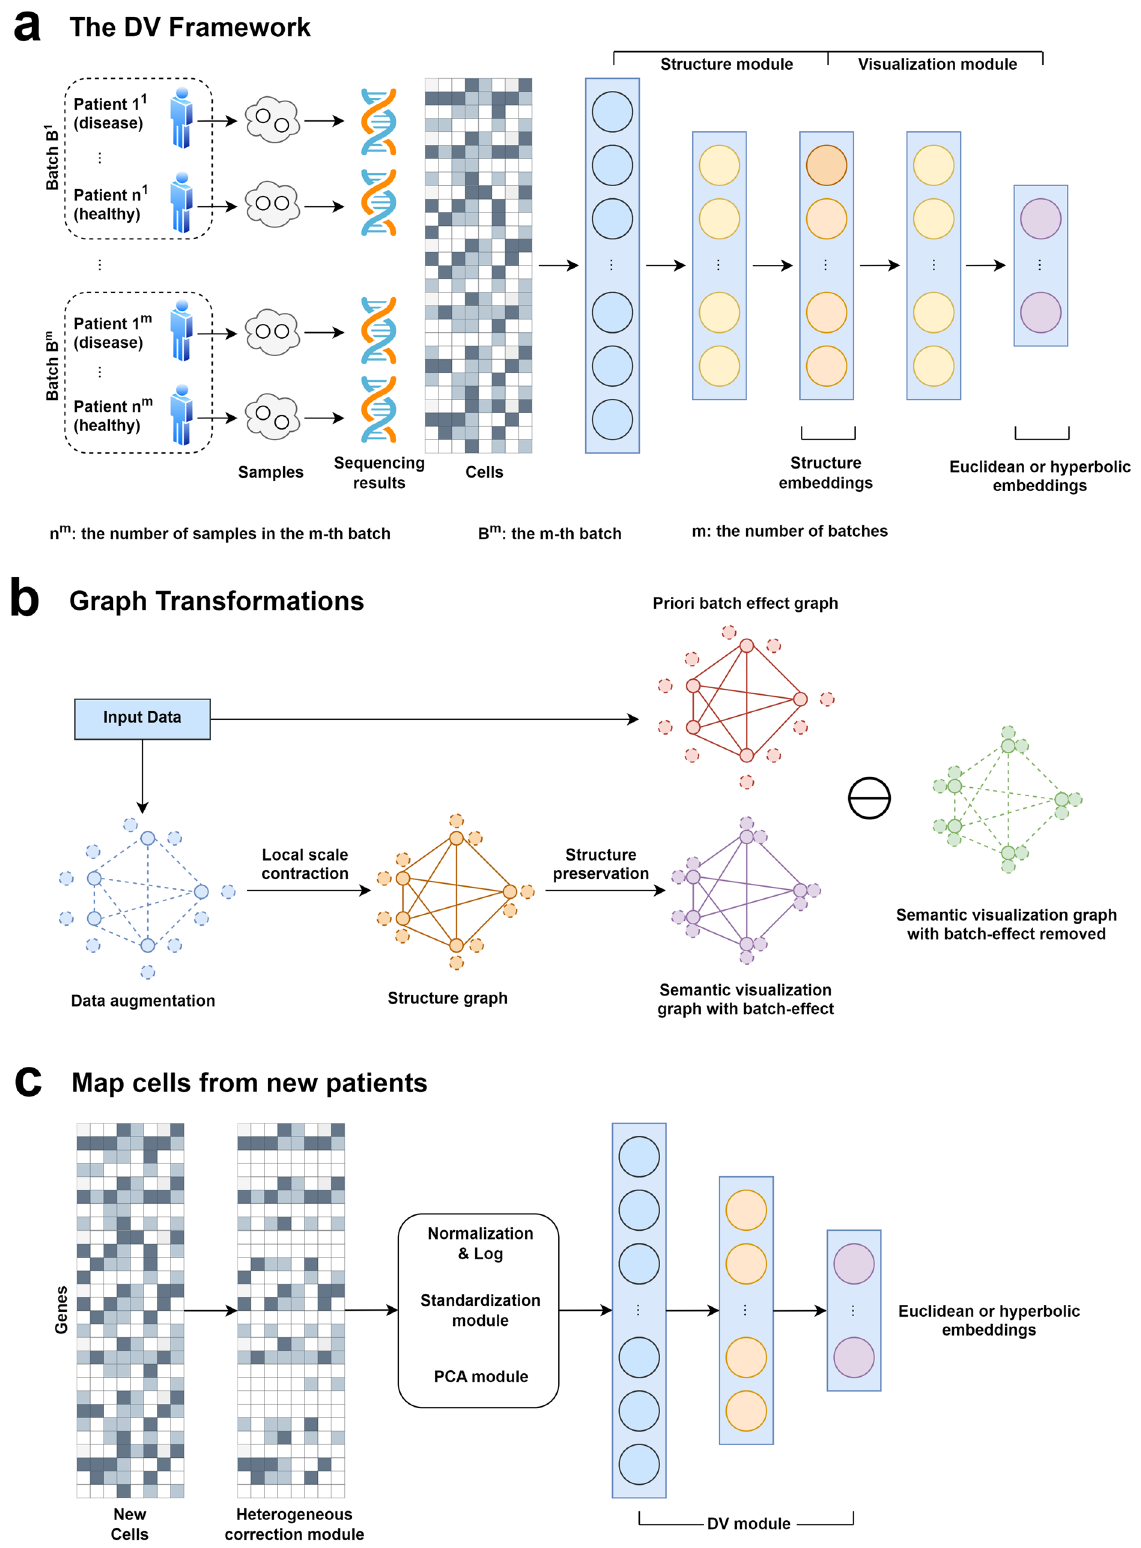
Fig. 1 The Deep Visualization (DV) model. a The DV framework. DV takes as input scRNA-seq measurements of multilevel technical or biological factors (e.g., replicate patient, disease) and learns the latent structure of cells while taking into consideration of batch effect. b DV learns a structure graph from the input based on local scale contraction, then in the process of preserving the geometric structure of scRNA-seq data, disentangles semantic visualization graph with batch effect into semantic visualization graph with batch-effect removed and priori batch effect graph. c The preprocessing modules for heterogeneous new datasets and the learned DV model are used for mapping new datasets to the